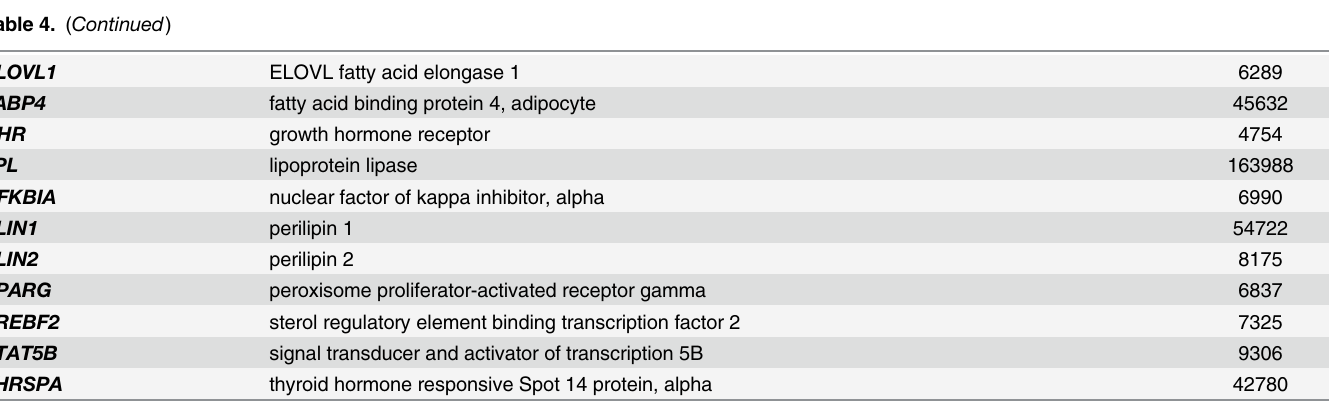
Comparison of highest-expressed (HE) and differentially-expressed (DE) genes identi fi ed by RNA-Seq analysis in abdominal fat of FL and LL chickens. Adipose genes with positive fold-change (FL/LL) values are expressed higher in the FL, while genes with a negative fold-change are expressed higher in LL chickens. Paired-end sequence reads for each gene were averaged across both genotypes (4 FL and 4 LL). The reads threshold for highest expressed (HE) genes was > 4289